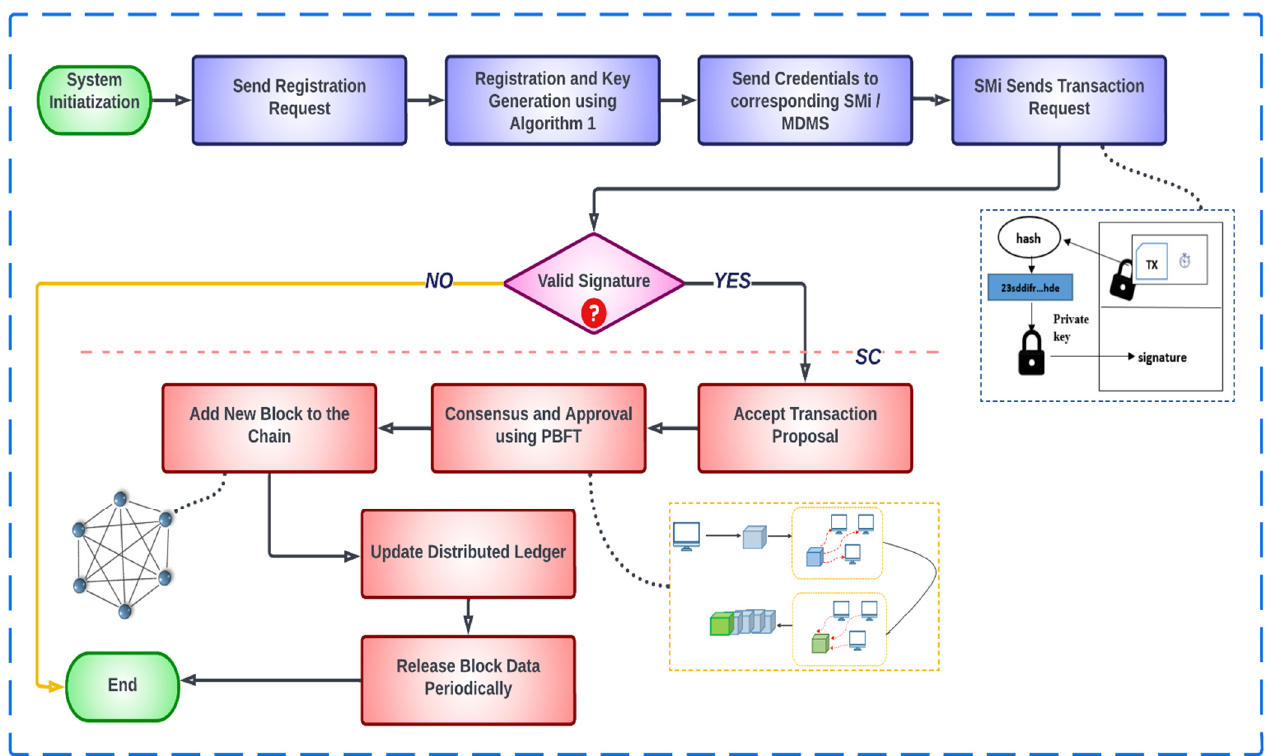
Figure 5. Workflow of proposed system model to illustrate the information transaction and validity from smart meter to permissioned blockchain via smart contract.